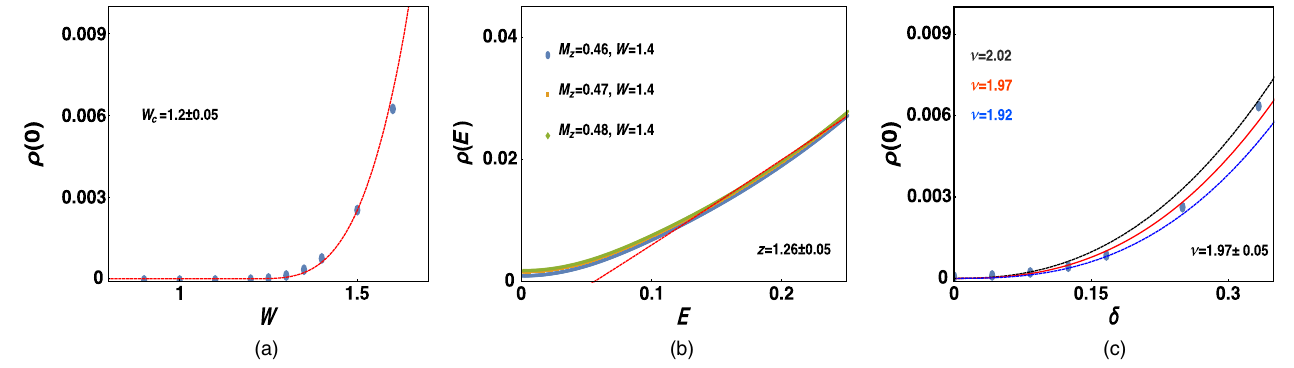
FIG. 7. Analysis of average density of states in various regimes along the black dashed line shown in Fig. 2 (left). Recall the black dashed line for weak disorder defines the phase boundary between the WSM and insulator, while when extended into the metallic phase [the red shaded regime in Fig. 2 (left)] captures the instability of critical excitations residing at the WSM-insulator QCP toward the formation of a metallic phase. (a) Scaling of average DOS at zero energy [ ϱ ð 0 Þ ] along the black dashed line as a function of increasing disorder ( W ), showing that ϱ ð 0 Þ remains pinned at zero up to a critical strength of disorder, W DOS at finite energy [ ϱ ð E Þ ] around the multicritical point residing in the two-dimensional coupling constant space ð m the dynamic scaling exponent for critical excitation-metal QPT is z ¼ 1 . 26 (cid:2) 0 . 05 . (c) Scaling of ϱ ð 0 Þ along the black dashed line inside the metallic phase indicating that correlation length exponent for critical excitation-metal QPT is ν ¼ 1 . 97 (cid:2) 0 . 05 . Details of the data analysis are presented in Sec. III B. The quoted error bars in z and ν are fitting error bars. See Appendix E and Table IV (last row) for further details of data